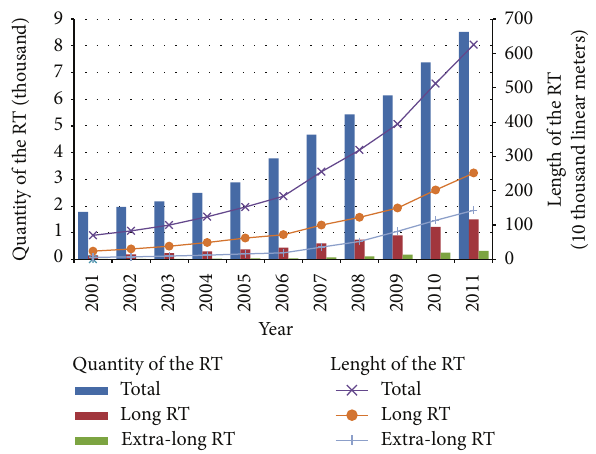
Figure1:Recentroadtunnel(RT)developmentinChina2001 ∼